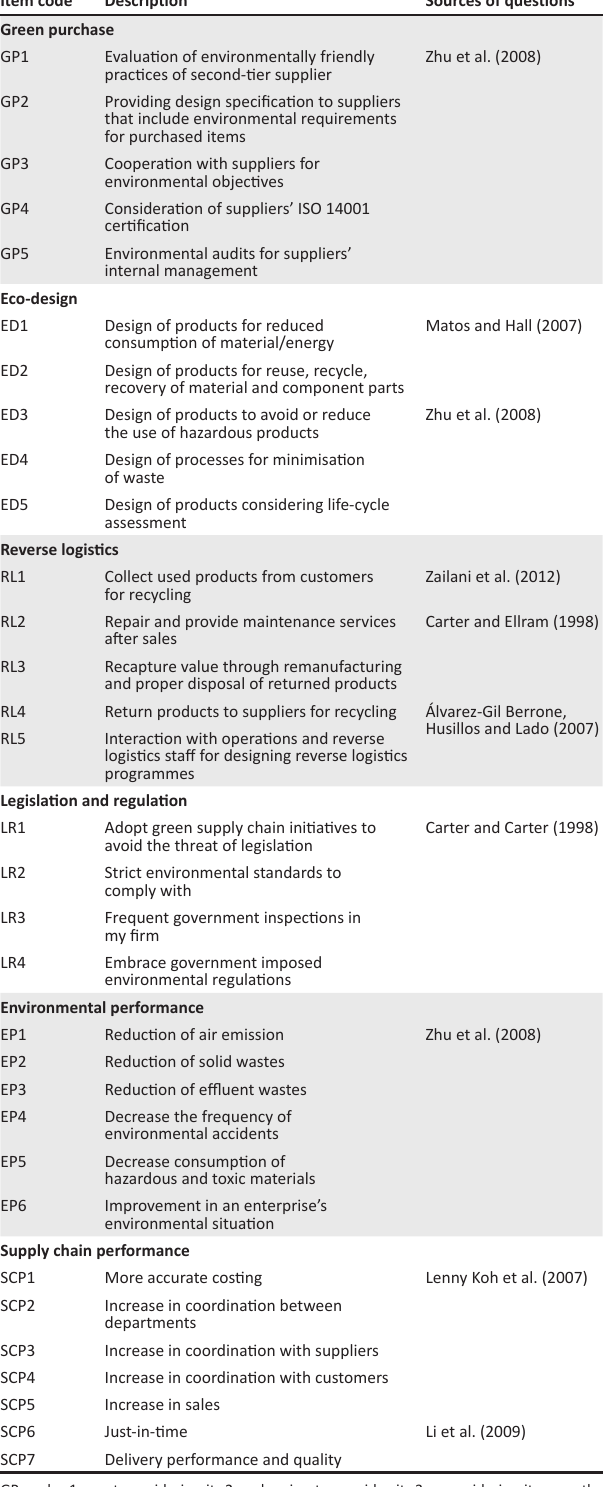
TABLE 2: Measurement scales and their